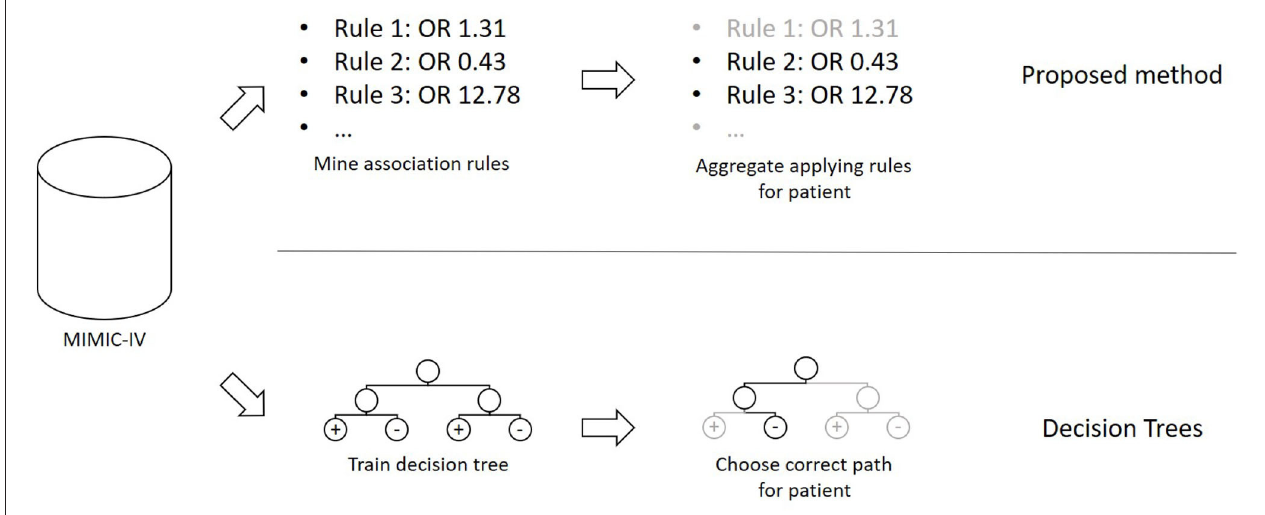
FIGURE 1 | The overall concept of the method in comparison to decision trees.